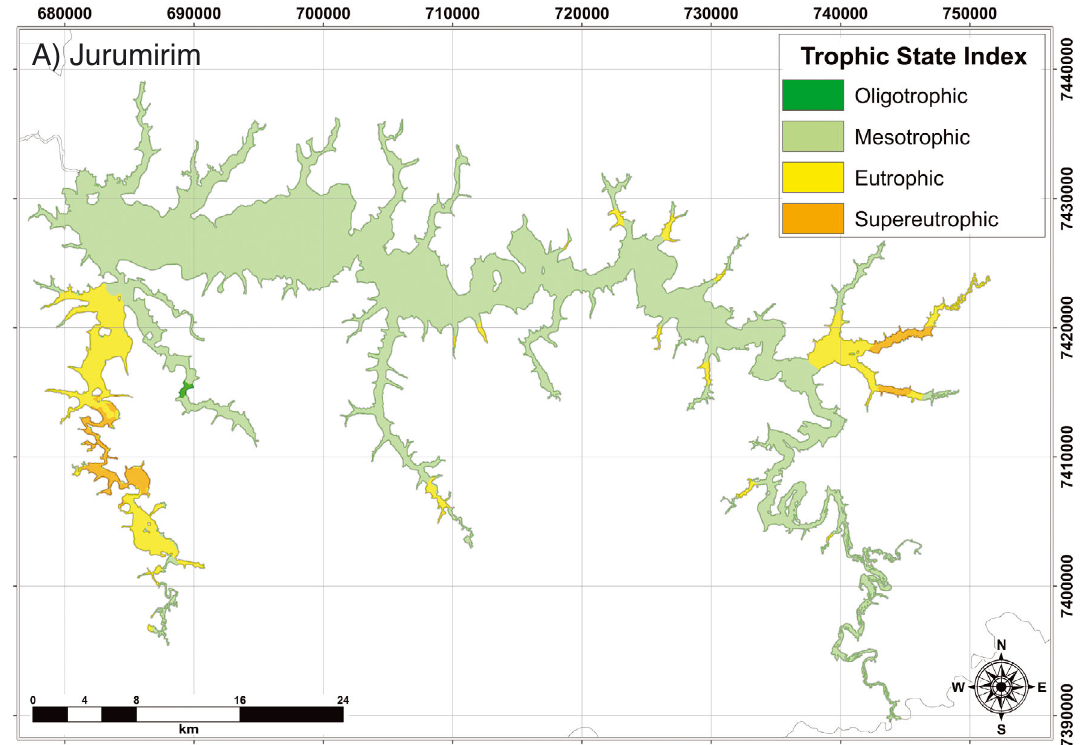
Fig. 2. Trophic state index under critical hydrodynamic conditions in the 8 large artificial reservoirs, Paranapanema River Basin, Brazil: (A) Jurumirim, (B) Chavantes, (C) Salto Grande, (D) Canoas II, (E) Canoas I, (F) Capivara, (G) Taquaruçu and (H) Rosana